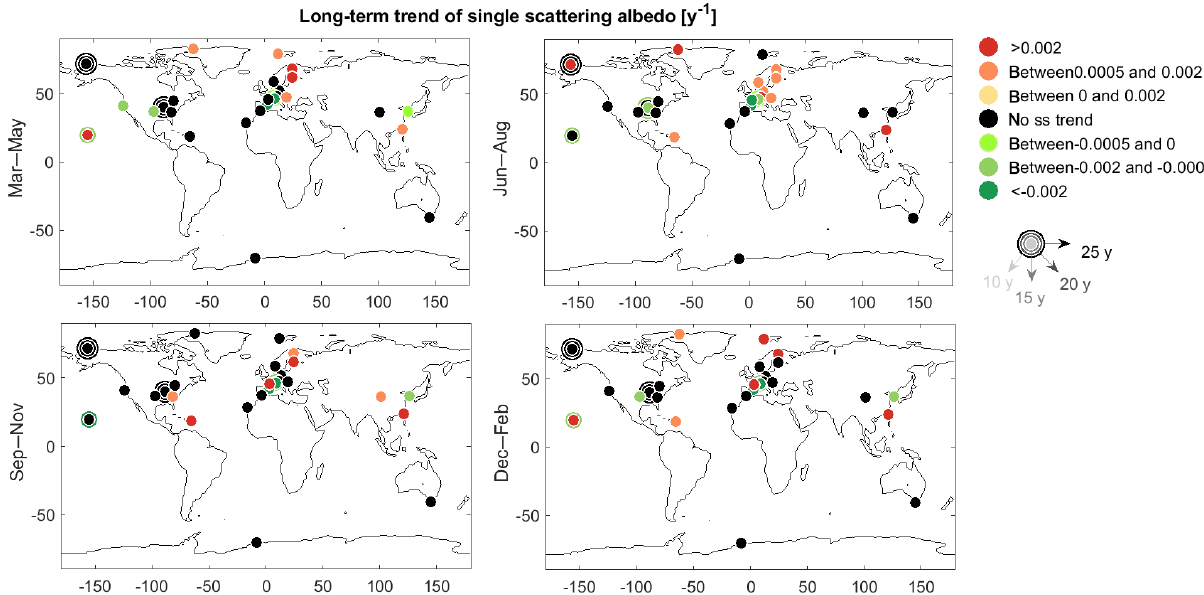
Figure 8. Seasonal results of the MK trend of the single scattering albedo. Other details same as Fig. 4.